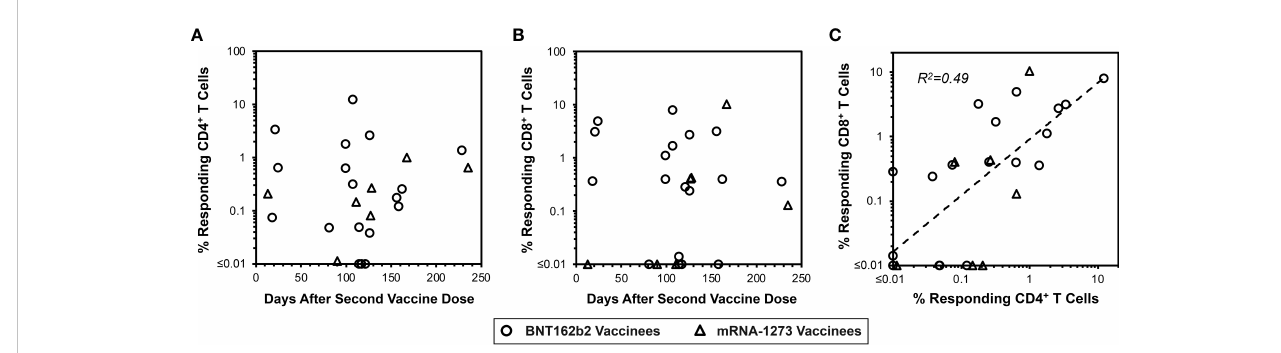
FIGURE 5 Vaccine-elicited spike-speci fi c memory CD4+ and CD8+ T cells are persistent. In parallel to Figure 3 panels A and B, the same PBMC from 22 vaccinees were assessed for spike-speci fi c T cell memory responses as shown in Figure 4. (A) 22/25 (88.0%) vaccinees had detectable spike-speci fi c CD4+ T cell memory responses of greater than 0.01% frequency (14/18 BNT162b2 vaccinees, circles, and 7/7 mRNA-1273 vaccinees, triangles). (B) 18/25 (76.0%) vaccinees had detectable CD8+ T cell memory responses greater than 0.01% frequency (15/18 BNT162b2 vaccinees, circles, and 4/7 mRNA-1273 vaccinees, triangles). (C) The frequencies of spike-speci fi c memory CD4+ and CD8+ T cells after in vitro enrichment are compared, demonstrating Pearson correlation r2 = 0.49,